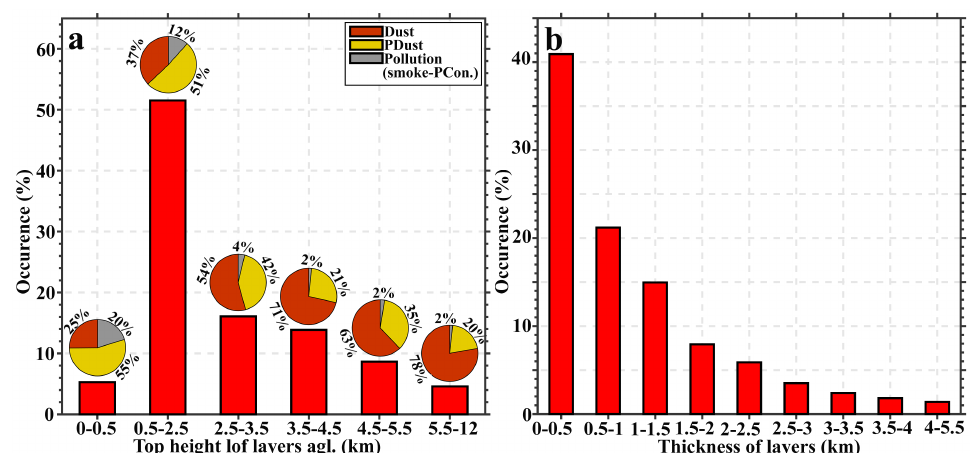
Figure 10. Histogram of ( a ) lofted-layer top heights and ( b ) depths during January 2018–December 2019. The type of observed aerosol layer has also been shown by a pie chart for each